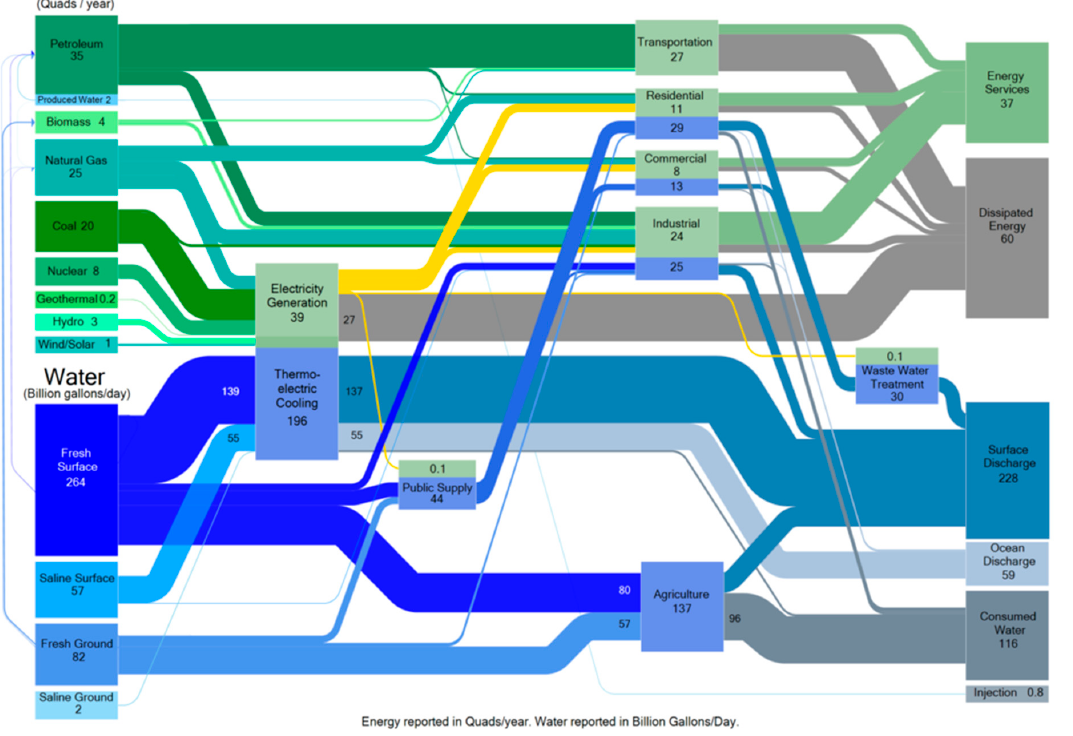
Figure 1. Sankey diagram for the water – energy nexus (adapted from [13]).